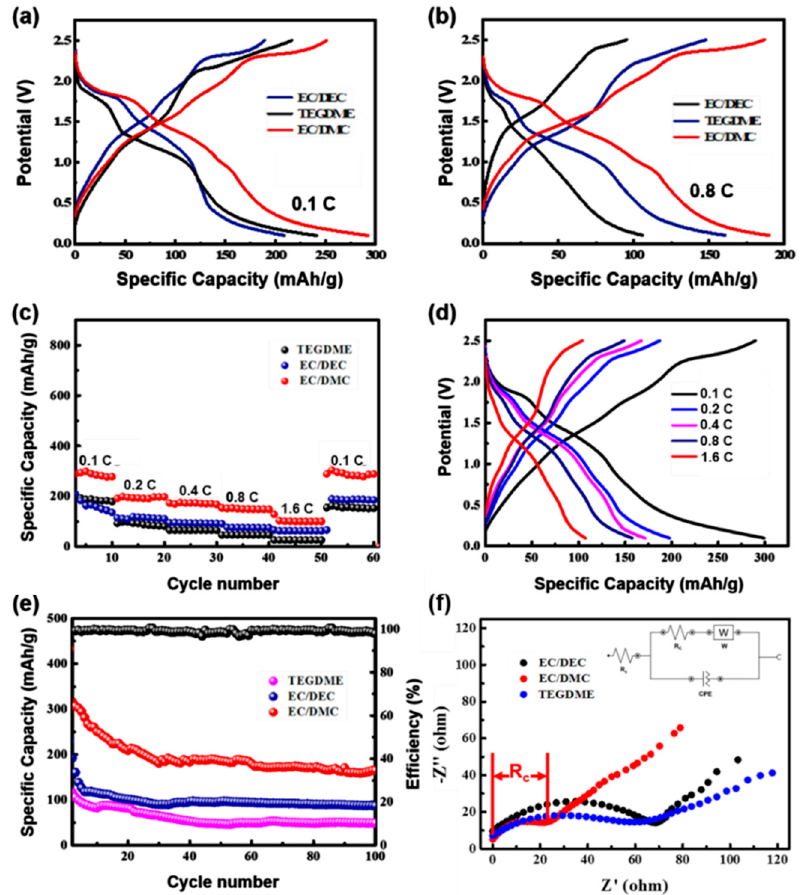
Figure 4. Electrochemical measurements of VS 4 nanorods with different electrolytes: ( a , b ) the charge-discharge curves at the current density of 0.1 C and 0.8 C, respectively; ( c ) rate performance; ( d ) the charge-discharge curves at different current densities of VS 4 nanorods in the EC/DMC electrolyte; ( e ) the cycling test at 0.4 C for 100 cycles; ( f ) EIS Nyquist impedance spectra.